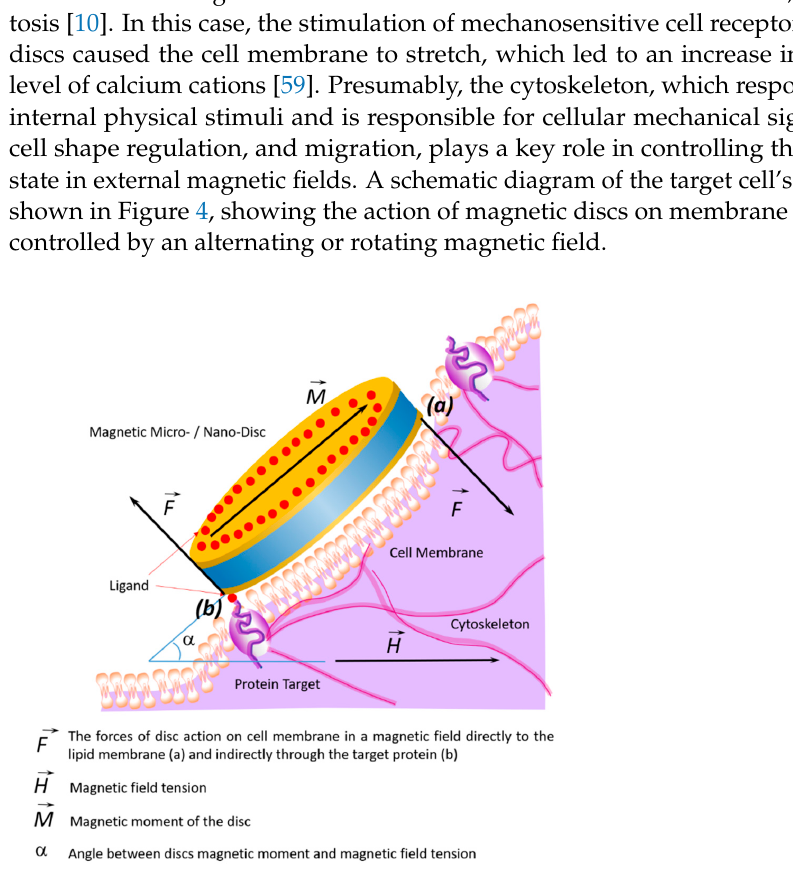
Figure 4. Schematic diagram showing changes of the target cell’s functional state under the influence of magnetic discs and the effects on membrane proteins in an alternating or rotating magnetic field. In a magnetic field, the discs’ forces act on the cell membrane and cytoskeleton in two ways: directly ( a ) or indirectly through the target protein ( b